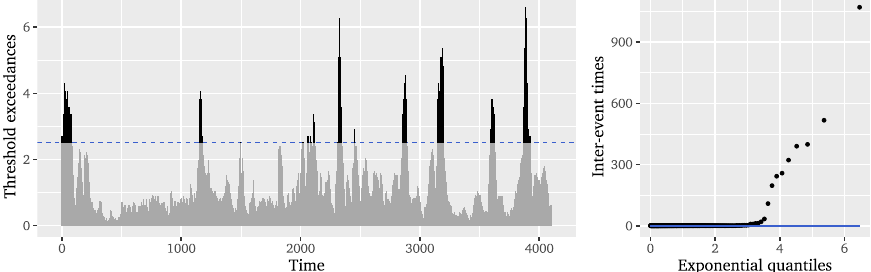
Figure 1. Offshore significant wave heights at Sefton coast from 10 September to 9 December 2013. Exceedances above a threshold u = 2.5 m, corresponding to 7.9% of the observations, and QQ plot of the inter-event times compared to a unit exponential